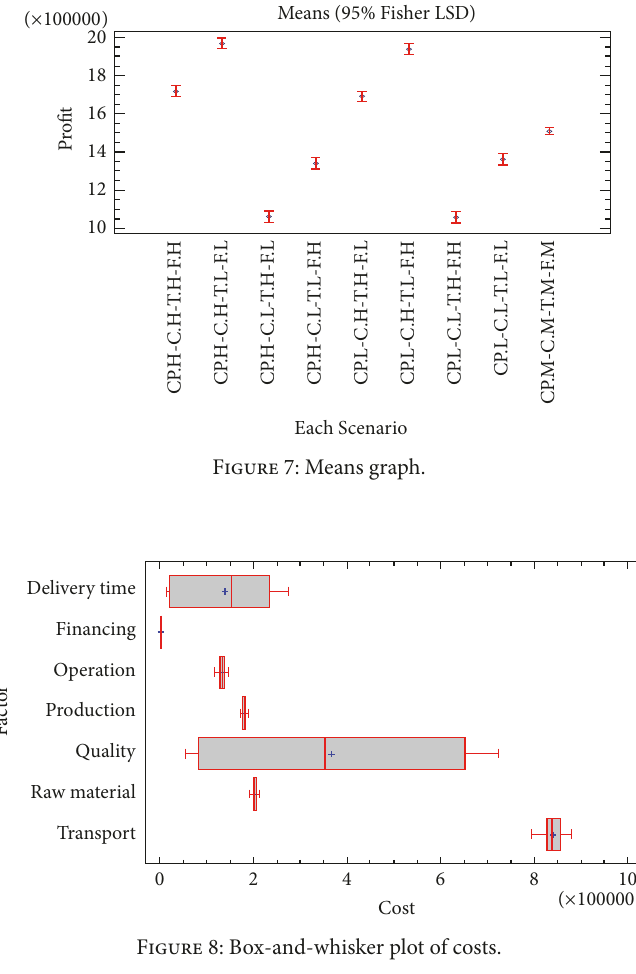
Figure 8: Box-and-whisker plot of costs.